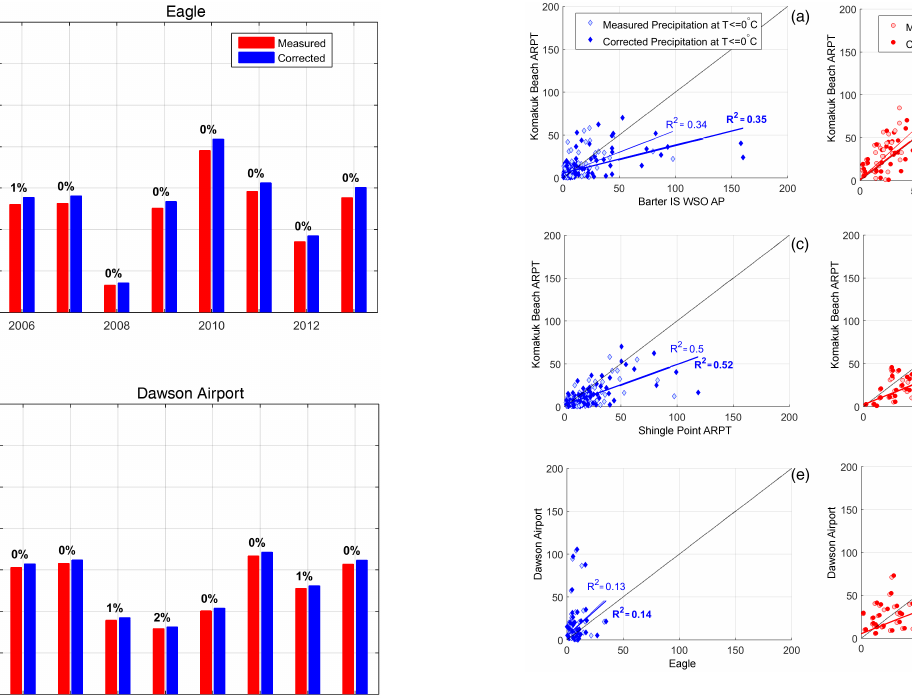
Figure 10. Scatter plots between station pairs for the measured and corrected precipitation (mm). The red colour shows warm months and the blue represents the cold months. (a) and (b) – Barter and Komakuk comparison across the border; the highest corrected val- ues for Barter (AK) are labelled with the date to compare with Fig. 4c and d – Komakuk and Shingle Point comparison within Canada. (e) and (f) – Eagle vs. Dawson across the border for the central